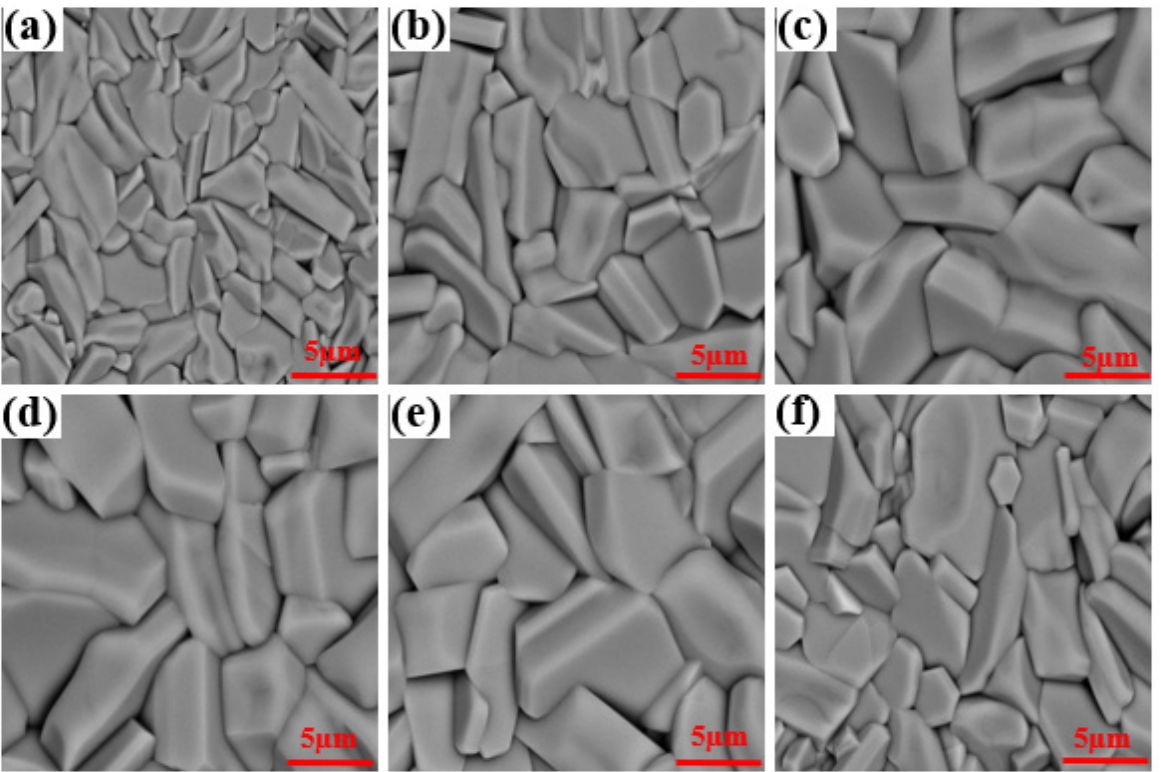
Figure 7. Backscatter SEM photographs of polished and annealed treatment fracture surfaces of Ba 1 − x Sr x (Zn 1/3 Nb 2/3 )O 3 ceramics with ( a ) x = 0, ( b ) x = 0.1, ( c ) x = 0.2, ( d ) x = 0.4, ( e ) x = 0.6, and ( f ) x = 0.8.